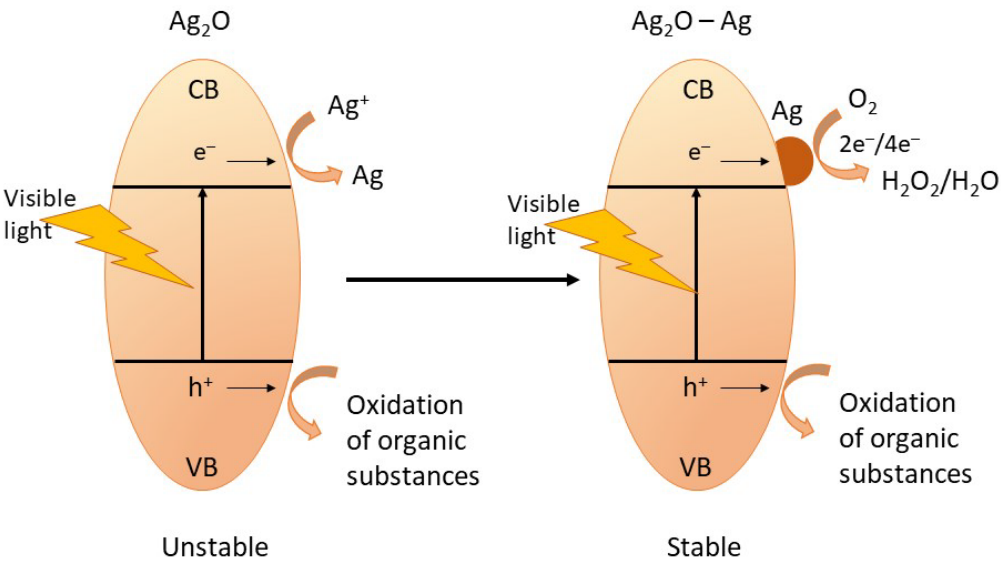
Figure 6. The schematic diagram showing the self-stabilizing process of Ag 2 O-NPs during photocatalysis. Adapted from Ref. [12], Copyright 2011.